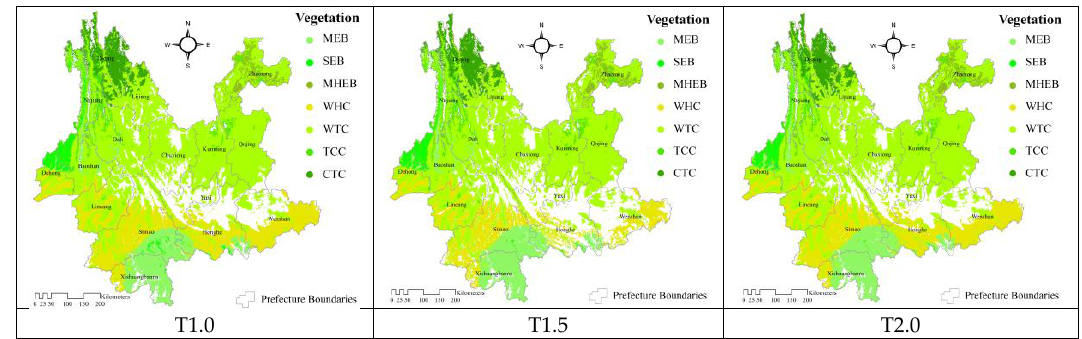
T1.0 T1.5 T2.0 Figure 2. The potential distribution of forest vegetation in Yunnan Province under current and different temperature increasing scenarios. MEB: Monsoon Evergreen Broad-leaved Forests; SEB: Semi-humid Evergreen Broad-leaved Forests; MHEB: Mountainous Humid Evergreen Broad-leaved Forests; WHC: Warm-hot Coniferous Forests; WTC: Warm-temperate Coniferous Forests; TCC: Temperate-cool Coniferous Forests; CTC: Cold-temperate Coniferous Forests. Table 5. The area and rate of change in forest distribution area under different temperature scenarios. Units: Area (×10 5 ha); Rate of change (%). T0.0 – Current Forest Vegetation